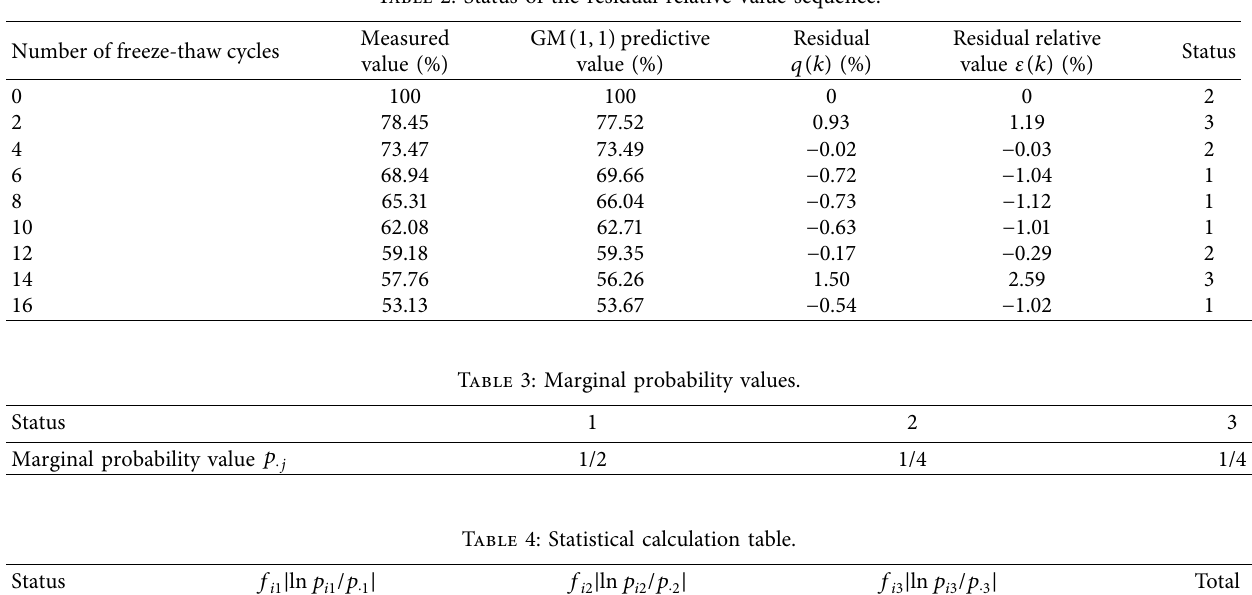
Table 2: Status of the residual relative value sequence.